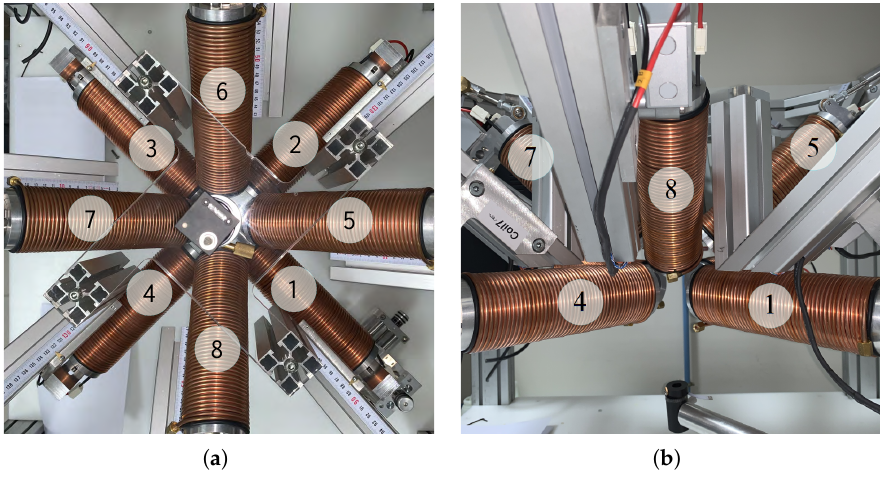
Figure 14. Photograph of the ( a ) top-view and ( b ) sideview of OctoRob